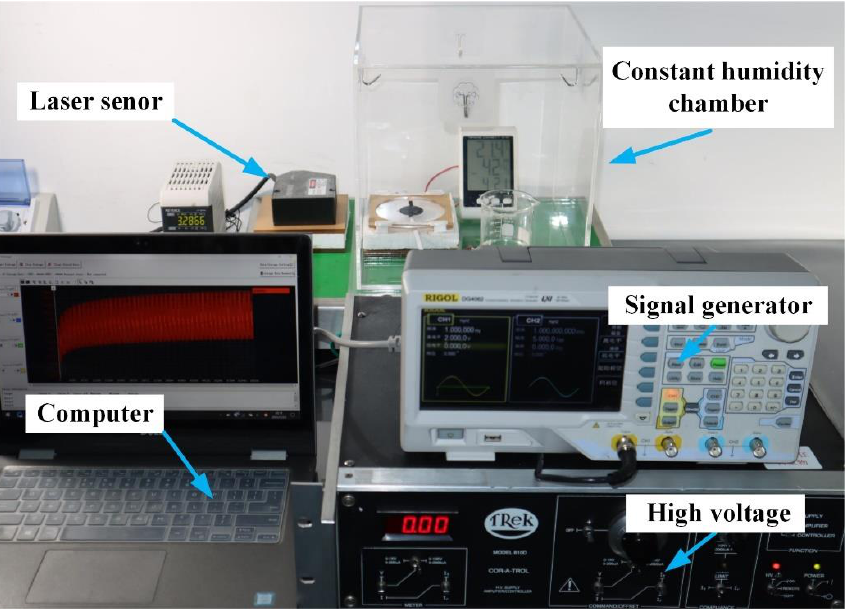
Figure 2. Experimental setups for electromechanical measurement of VHB 4905 film under different humidity levels.